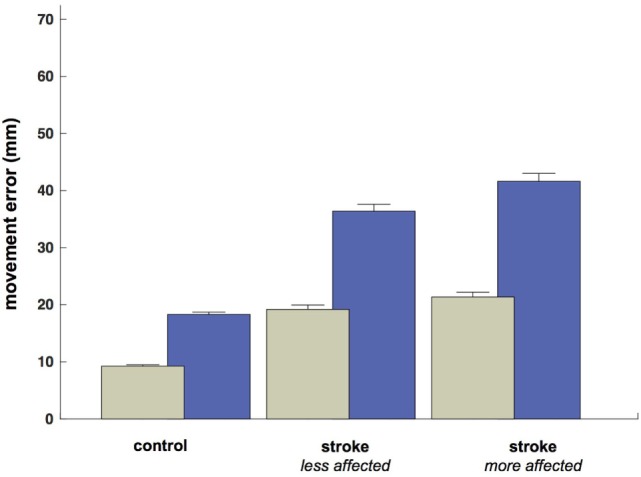
Average endpoint error by participant grouping and/or arm (mm at the screen). Green bars show average reach error, and blue bars show average (primary) saccade error.